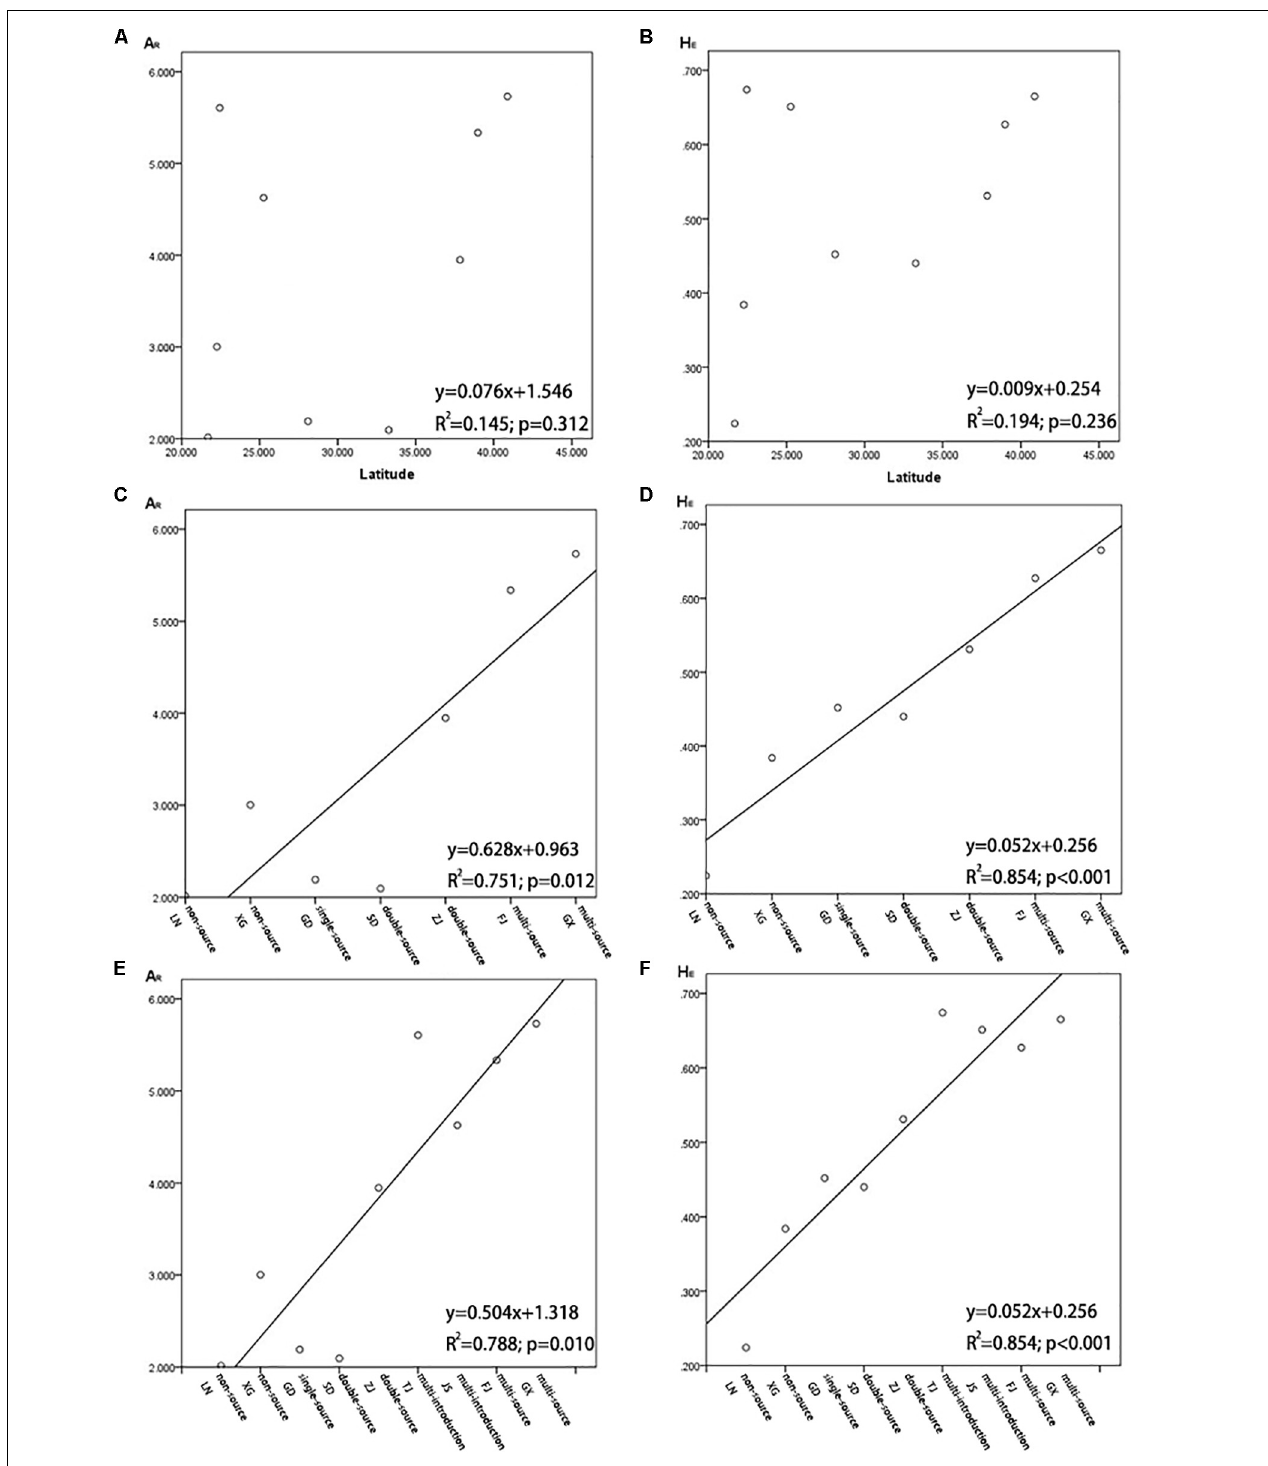
FIGURE 8 | (A) Population allelic richness ( A R ) in relation to latitude of Spartina alterniflora in China; (B) population expected heterozygosity ( H E ) in relation to latitude of S. alterniflora in China; (C) population allelic richness ( A R ) in relation to the number of sources when S. alterniflora was introduced into coastal China for the first time (1980s), and it is not including HB and JS; (D) population expected heterozygosity ( H E ) in relation to the number of sources when S. alterniflora was introduced into coastal China for the first time (1980s), not including HB and JS; (E) population allelic richness ( A R ) in relation to the number of sources when S. alterniflora was introduced into coastal China for the first time (1980s), including HB and JS; (F) population expected heterozygosity ( H E ) in relation to the number of sources when S. alterniflora was introduced into coastal China for the first time (1980s), including HB and JS.